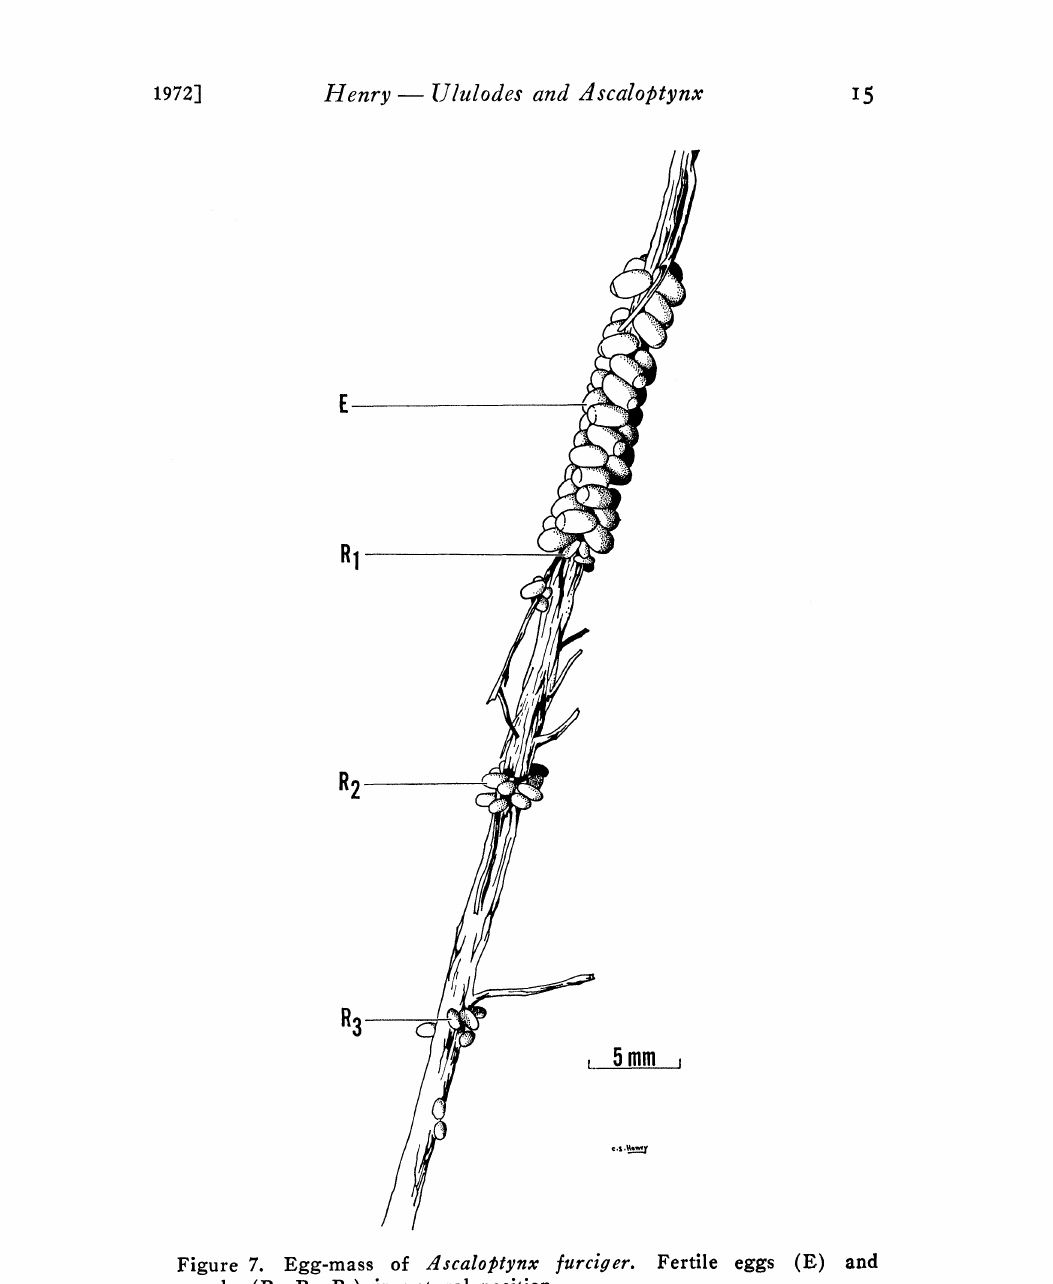
Figure 7. Egg-mass of .4scalotynx [urciger. Fertile eggs (E) and repagula (R1, R2, R,) in natural